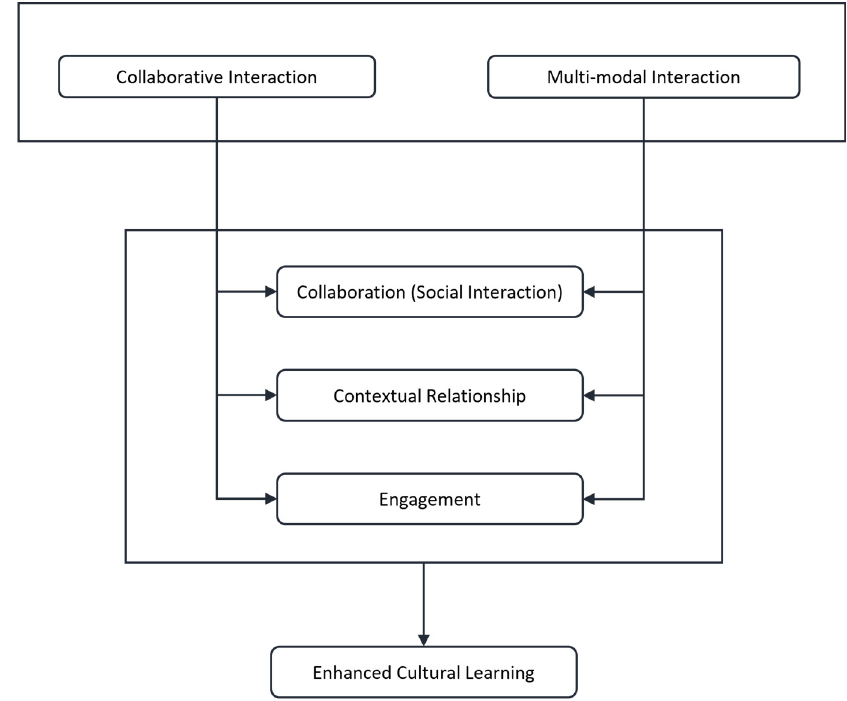
Figure 1. Conceptual